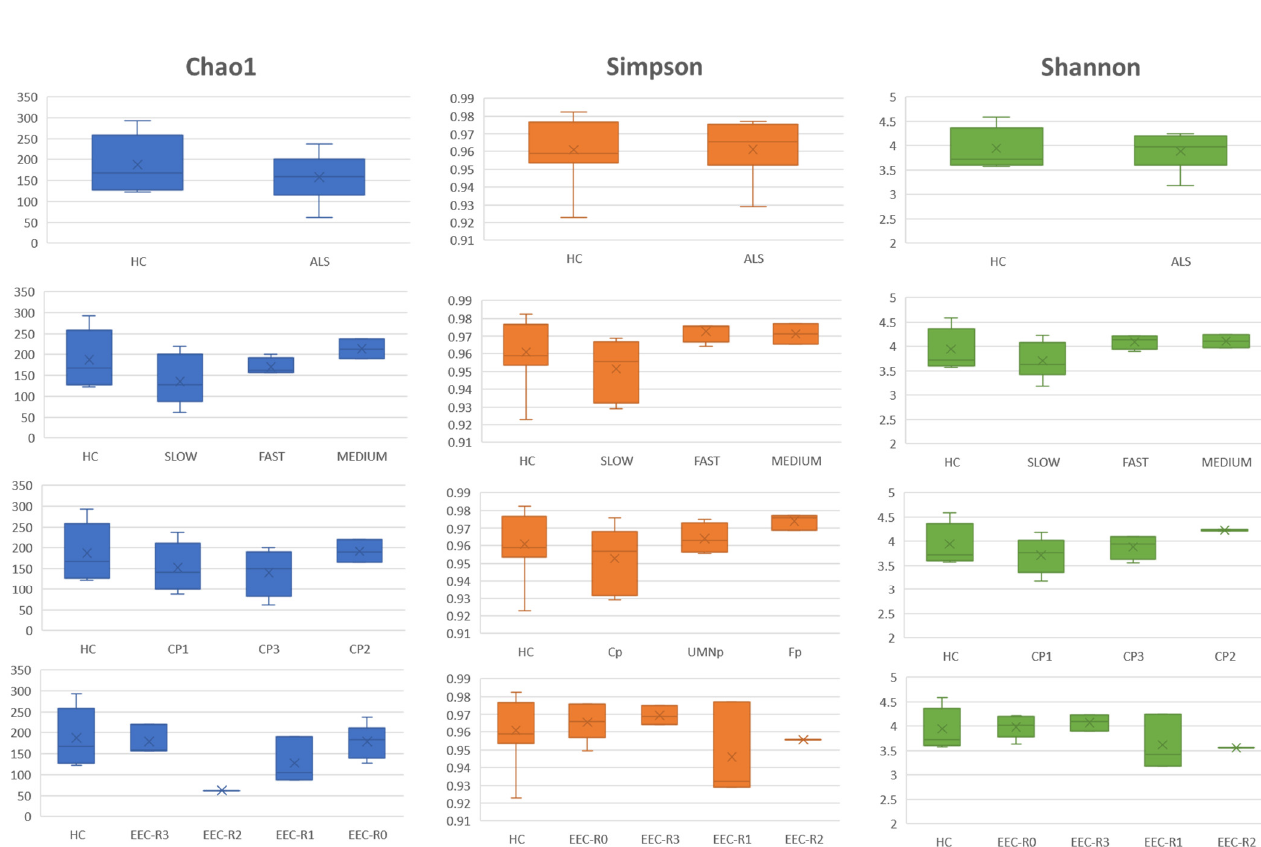
Figure 2. Boxplots displaying the Chao1, Simpson and Shannon alpha-diversity index of fecal samples among patient subgroups and controls. ALS = amyotrophic lateral sclerosis. HC = healthy controls. EEC = EL Escorial Criteria; EEC-R0 = definite; EEC-R1 = clinically probable; EEC-R2 = probable-laboratory supported; EEC-R3 = possible. Bp = Bulbar phenotype; Cp = Classic phenotype; Fp = Flail arm/leg phenotype; UMNp = Upper Motor Neuron predominant phenotypes.